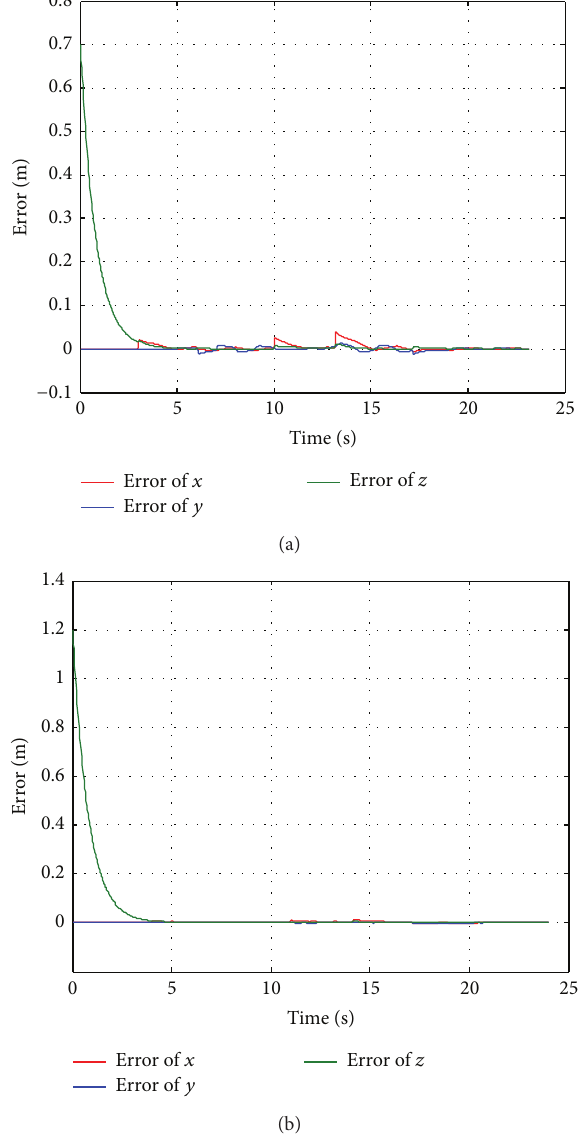
Figure 17: Position error of quadrotor: (a) without input shaper, (b) with input